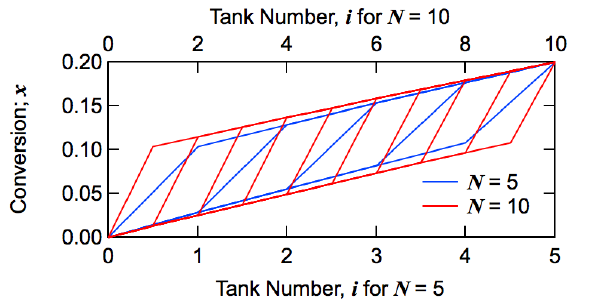
Figure 10. Development of monomer conversion to polymer x with the progress of tank number i for N = 5 (blue) and N = 10